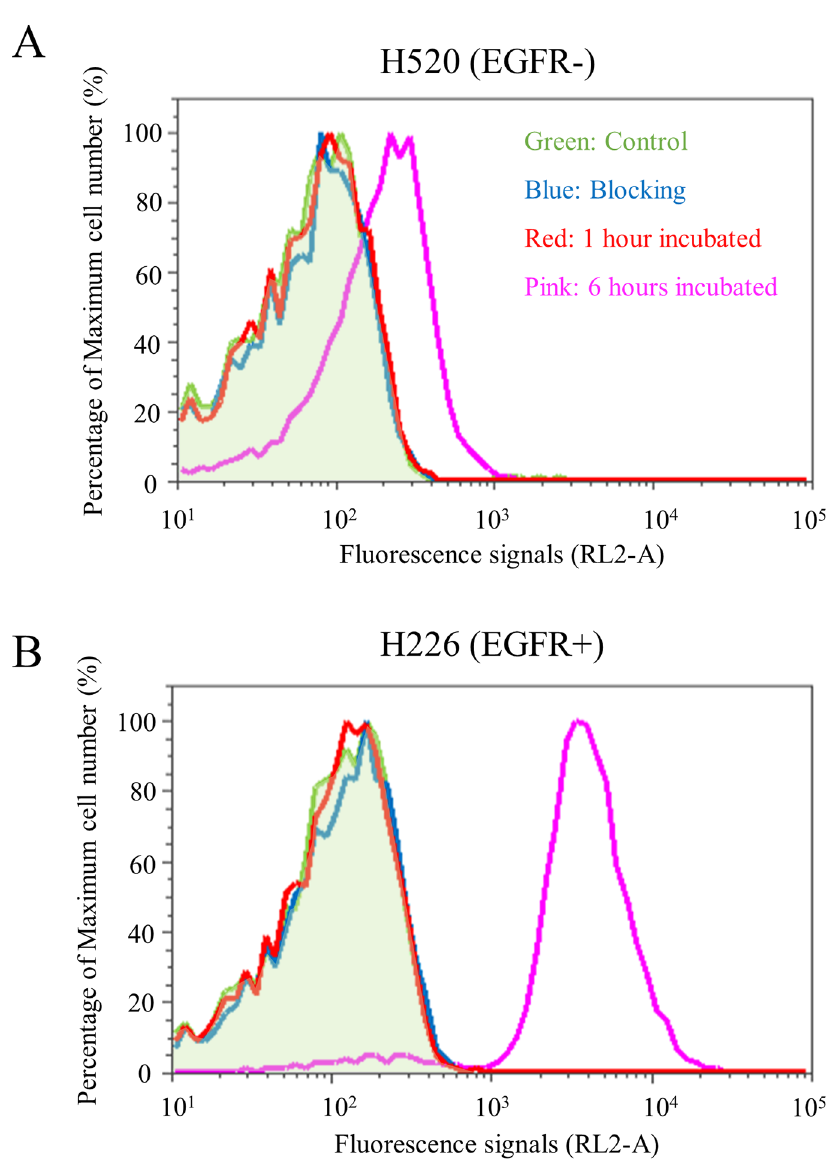
Fig 2. Flow cytometry analysis of H520 and H226 cell lines binding to Pan-ICG. In vitro cell experiment with flow cytometry showed (A) non-specific weak binding of Pan-ICG to EGFR- cell line at 6 hours and (B) specific binding of Pan-ICG to EGFR+ cell line at 6